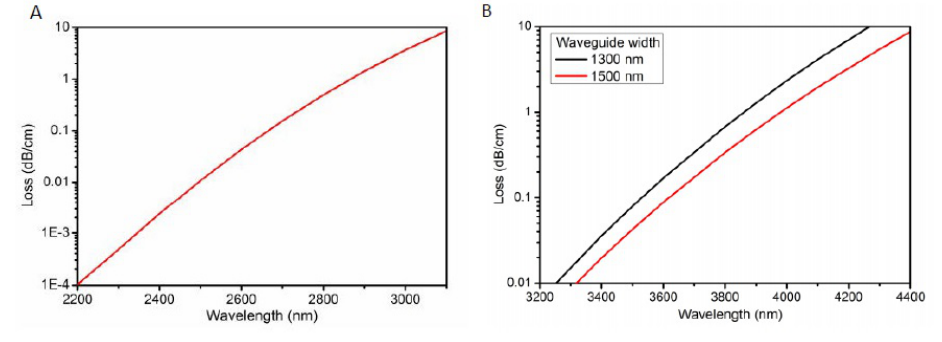
Fig. 11. (a) Substrate leakage of a 900 nm wide air-clad strip waveguide with a height of 220 nm (fundamental TE mode) as a function of wavelength; (b) substrate leakage loss of a 1300 and 1500 nm wide strip waveguide, etched in a 400 nm thick silicon waveguide layer as a function of wavelength (fundamental TE mode).